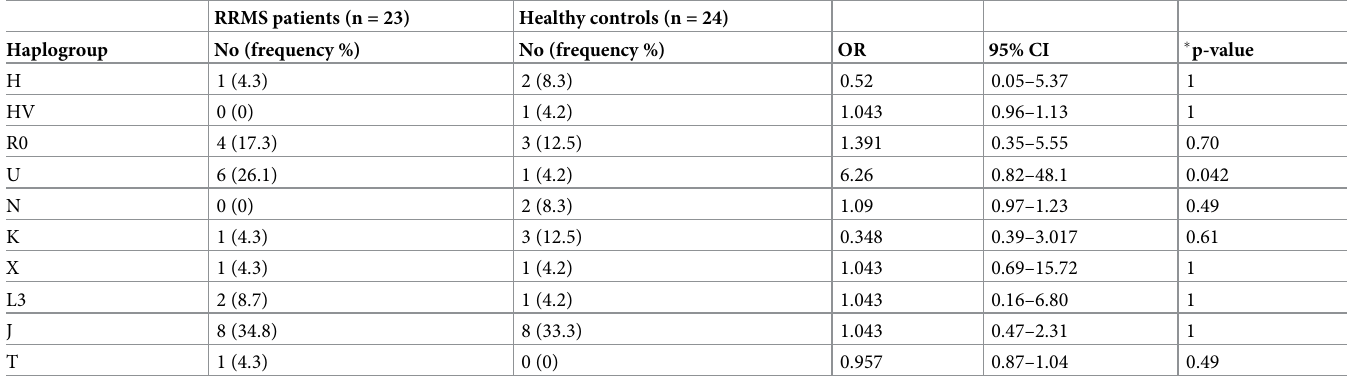
Table 2. Association of mitochondrial haplogroups with the susceptibility to MS. RRMS patients (n = 23) Healthy controls (n =